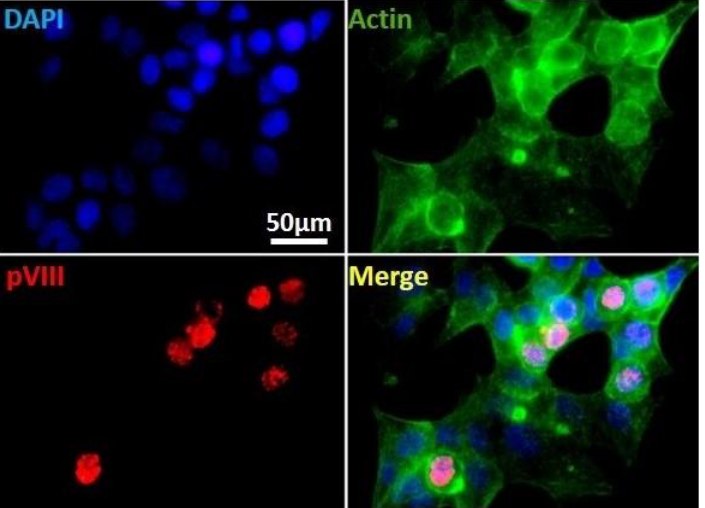
Figure 2. Immunofluorescence staining of HAdV pVIII protein in HAdV-F41-infected HCT116 cells. Cells infected with HAdV-F41 (MOI 0.5) at day 2 post-infection showing nuclear localization of the viral structural pVIII protein (red). Actin fibers and cell chromatin are presented in green and blue, respectively. Samples were analyzed under an Olympus BX51 IF microscope coupled with a CCD camera Acquired channels were merged using ImageJ software v1.53a. Uninfected cells or secondary Ab alone yielded no relevant signals.